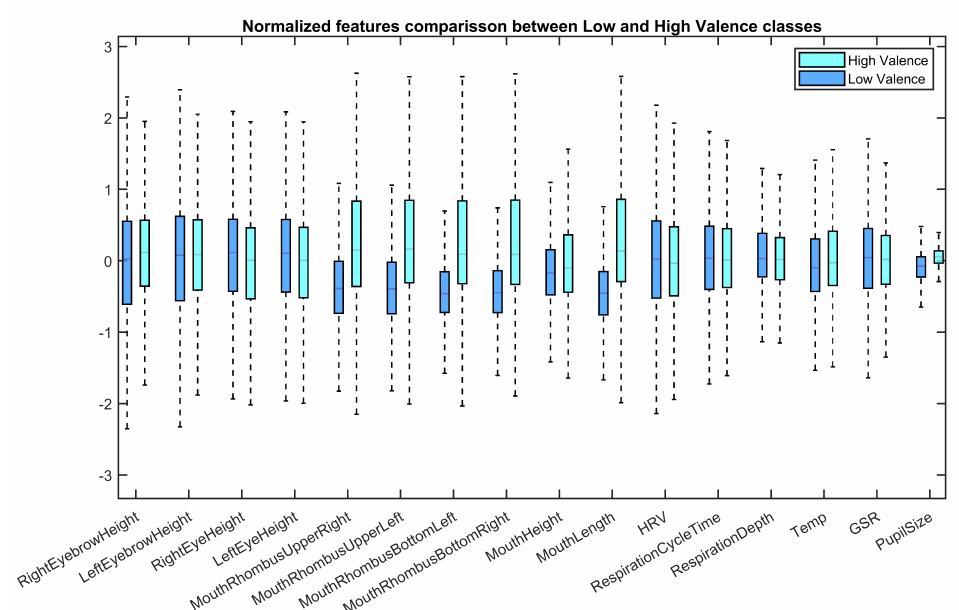
Figure 5. Boxplot for features in Mahnob-HCI dataset for valence emotional